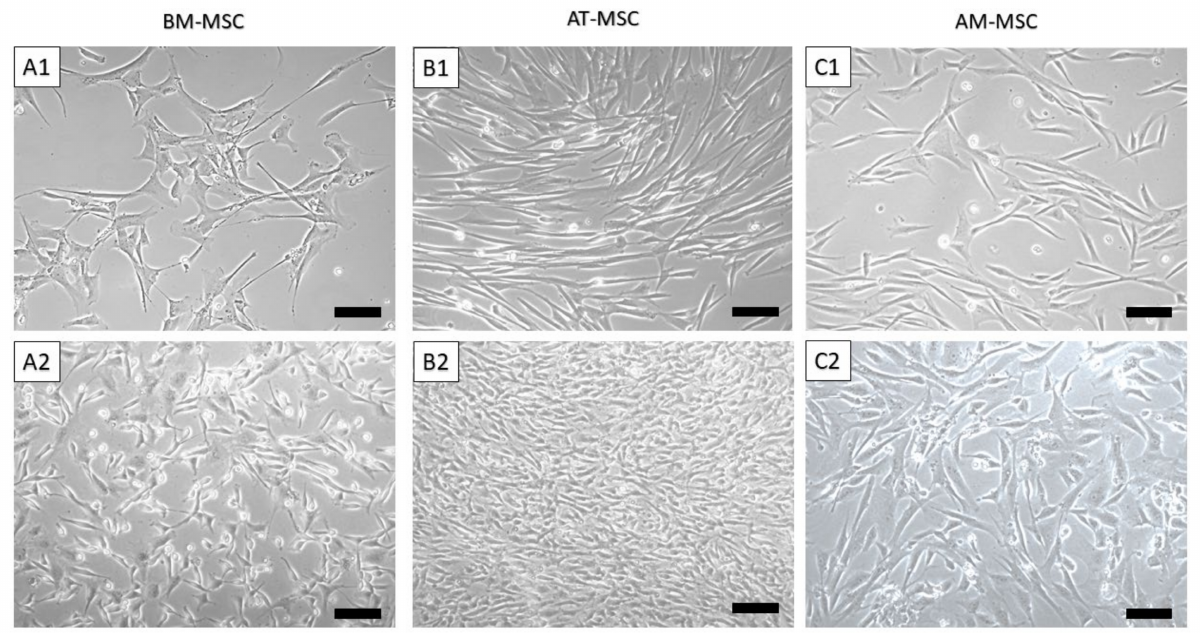
Figure 1. Detailed morphology of canine MSCs at passage 0 (P0) day in vitro (DIV) 3 from different sources. The BM-MSCs ( A ) and AM-MSCs ( C ) revealed a fibroblast-like morphology, while the AT-MSCs ( B ) showed a spindle-like morphology. Scale bars = 20 µ m.